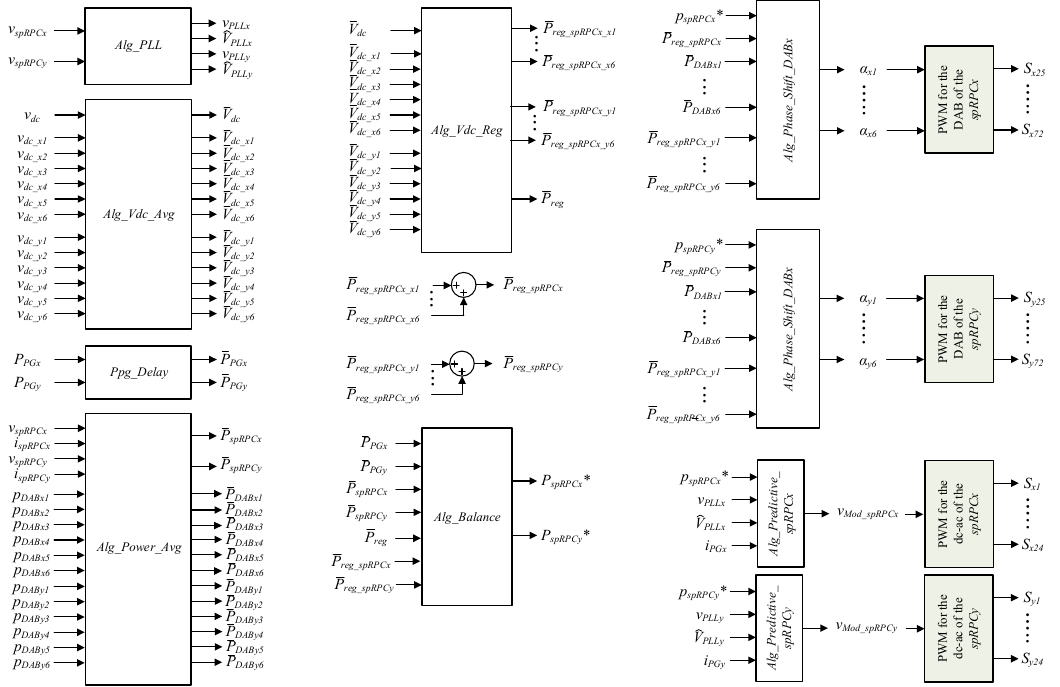
Figure 4. Block diagram of all the control algorithms implemented for the proposed sp-RPC. Once all the operating reference values have been determined, it is necessary to acti- based on the modulation technique used. For the SST, the control is done by the phase- shift technique, with the control algorithm Alg_Phase_Shift_DABx responsible for gener- ating the phase angles for each SST that constitutes the spRPCx . At the same time, the